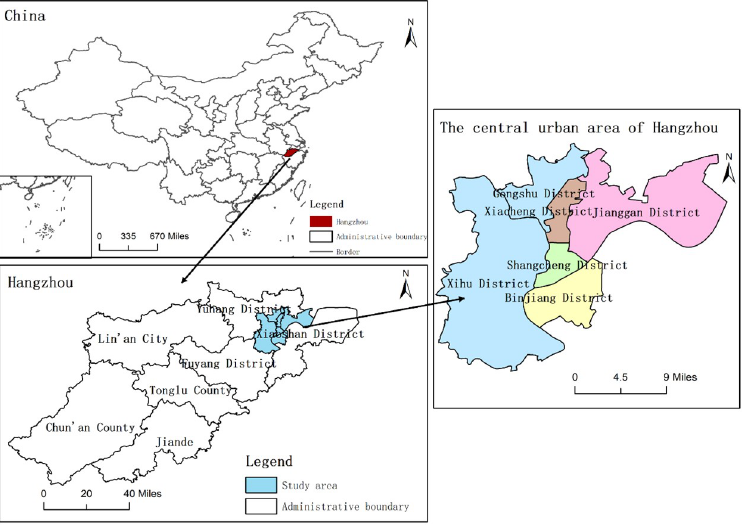
Fig 1. Map of the study area. The administrative division data are from the 1:250,000 basic geographic database provided the National Geomatics Center of China (http://www.ngcc.cn/ngcc/html/1//391/392/16114.html), these data are available free of